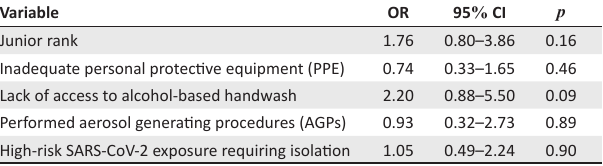
TABLE 4: Multiple variable logistic regression: Risk factors for SARS-CoV-2